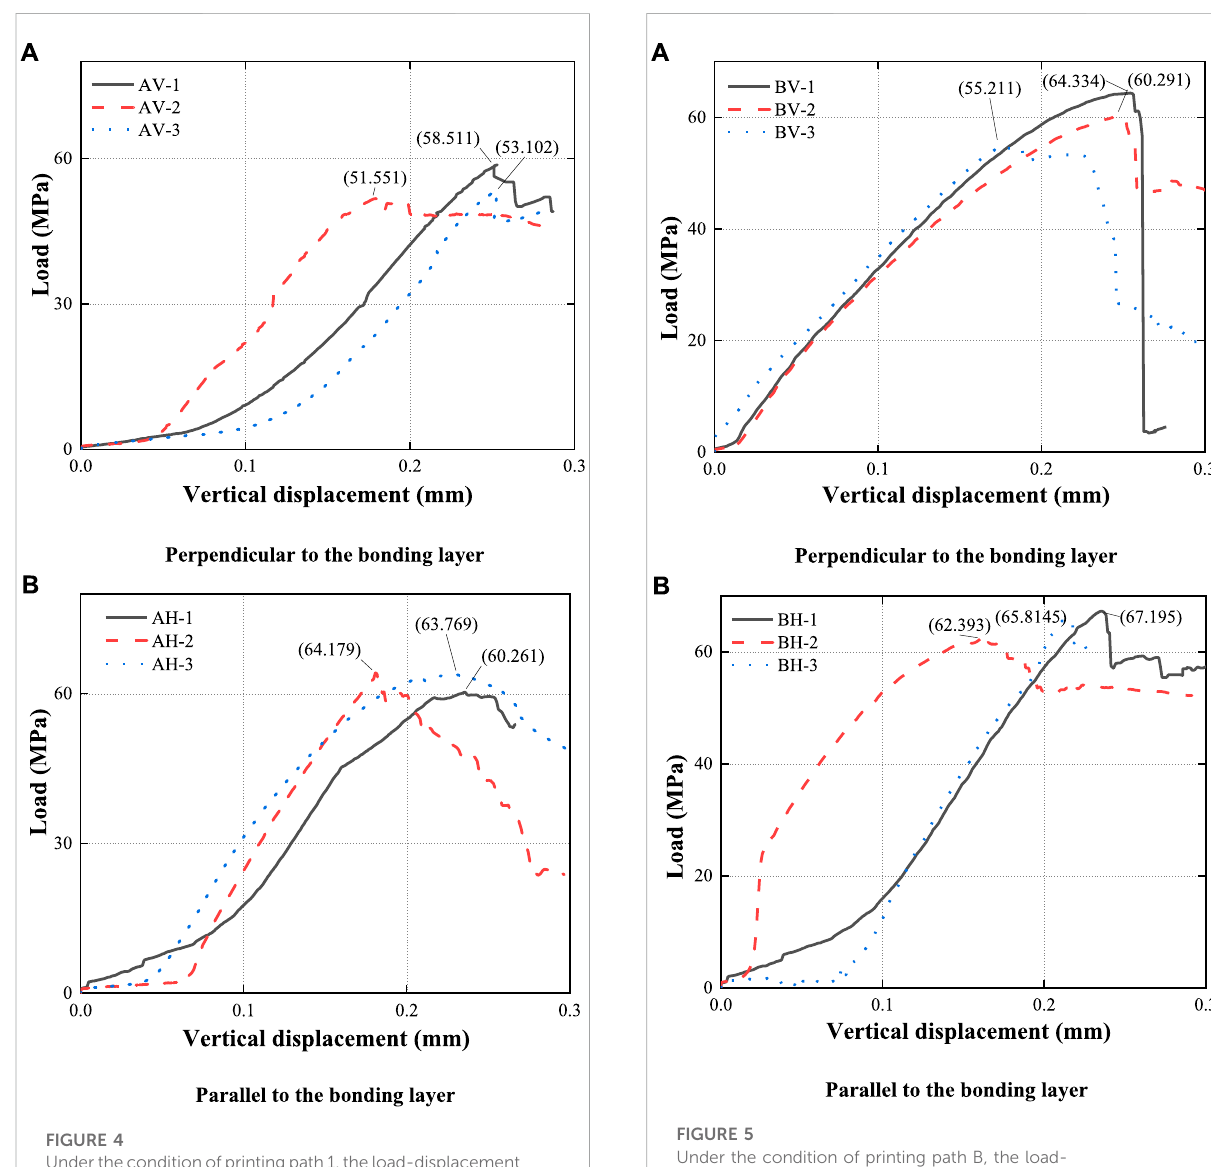
FIGURE 5 Under the condition of printing path B, the load- displacement curve of the specimen.